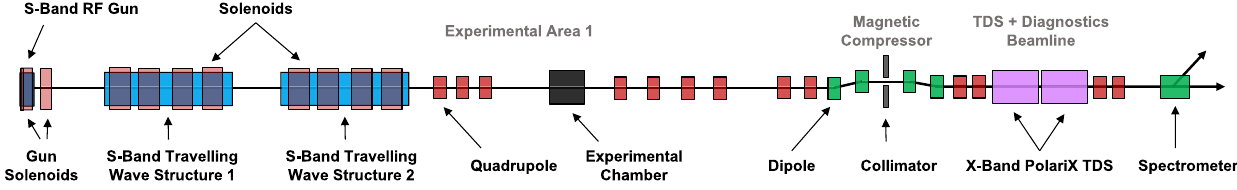
FIG. 6. Schematic of the layout of the ARES linac at DESY (not to scale). The LPSS interaction is simulated to take place in the experimental chamber of Experimental Area 1 at z ¼ 16 . 8 m.